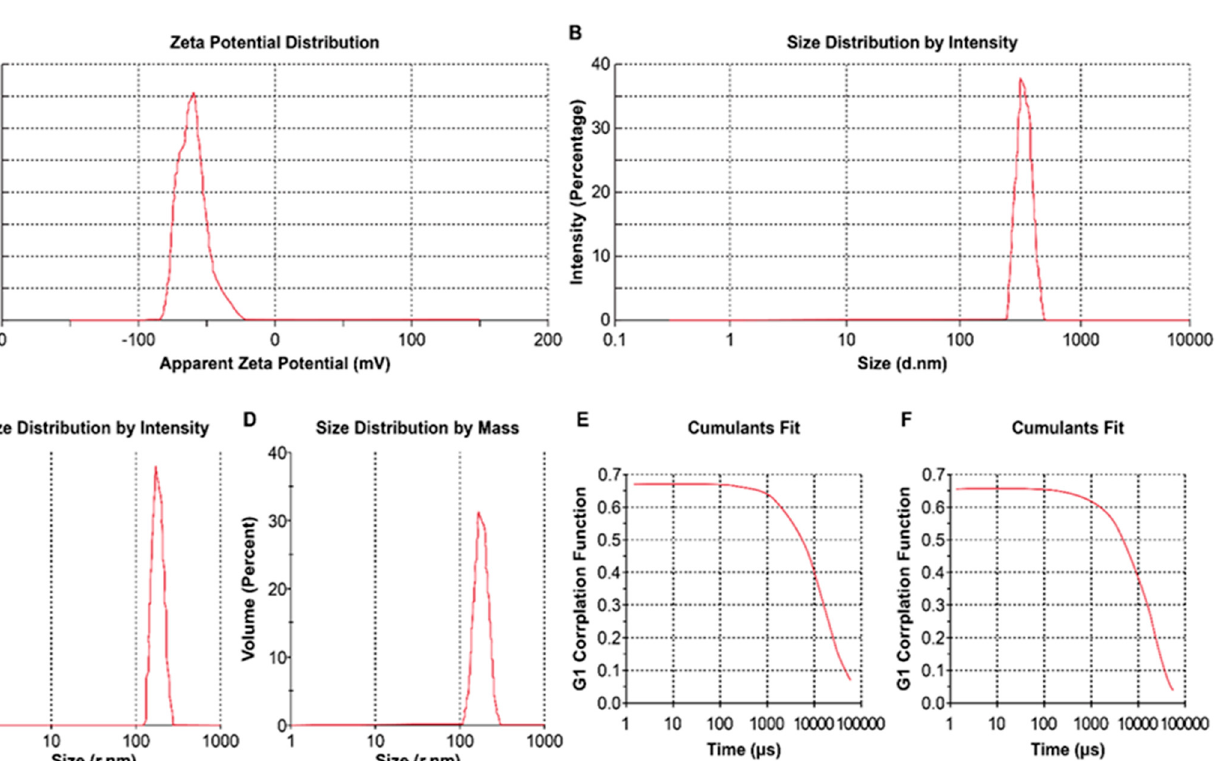
Table 1. Physical characterization of lyophilized recombinant HBsAg-loaded docosahexaenoic acid nanovesicles.